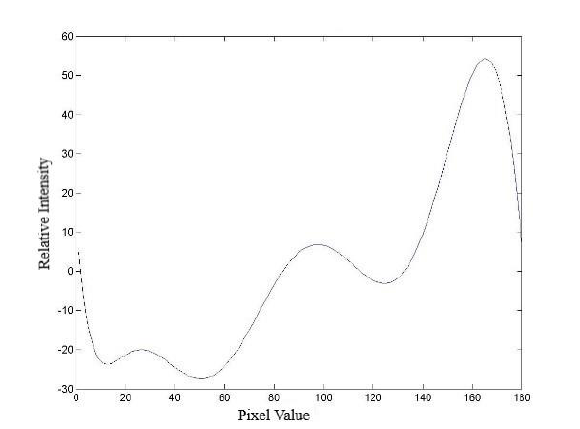
Figure 5. Eight-order nonlinear trend terms